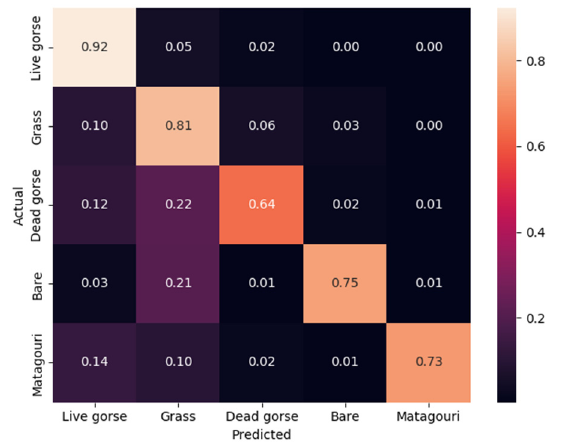
Figure 4. Percentage-wise confusion matrix showing per class accuracy (equivalent to recall along the diagonals) and misclassification proportions (non-diagonals) for the various manual fuel type annotations compared with model predictions for the test dataset of 27,620,352 pixels (37 images).